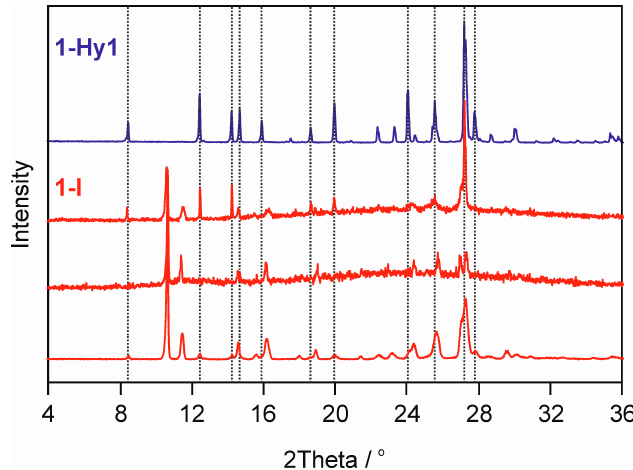
Figure 7. PXRD diffractograms of 1-Hy1 and 1-I . Note that some of the anhydrate patterns contain significant amounts of 1-Hy1 . Dotted lines mark characteristic 1-Hy1 peak positions.